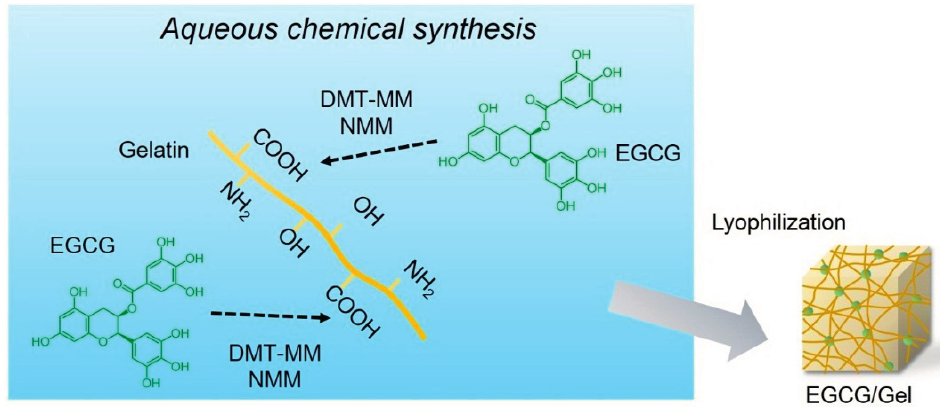
Figure 1. Schematic diagram of the epigallocatechin-3-gallate/gelatin complex (EGCG/Gel) preparation. EGCG/Gels were synthesized using a chemical reaction in water with 4-(4,6-dimethoxy-1,3,5-triazin-2-yl)-4-methyl-morpholinium chloride (DMT-MM) and N -methylmorpholine